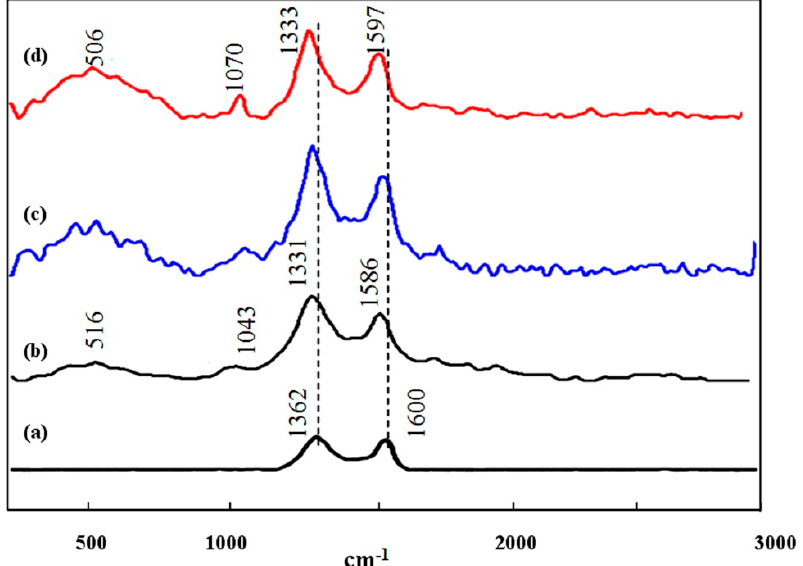
Figure 8. Raman spectra of ( a ) prepared graphene, ( b ) nanohybrid NH1, ( c ) nanohybrid NH2 and ( d ) nanohybrid NH3.